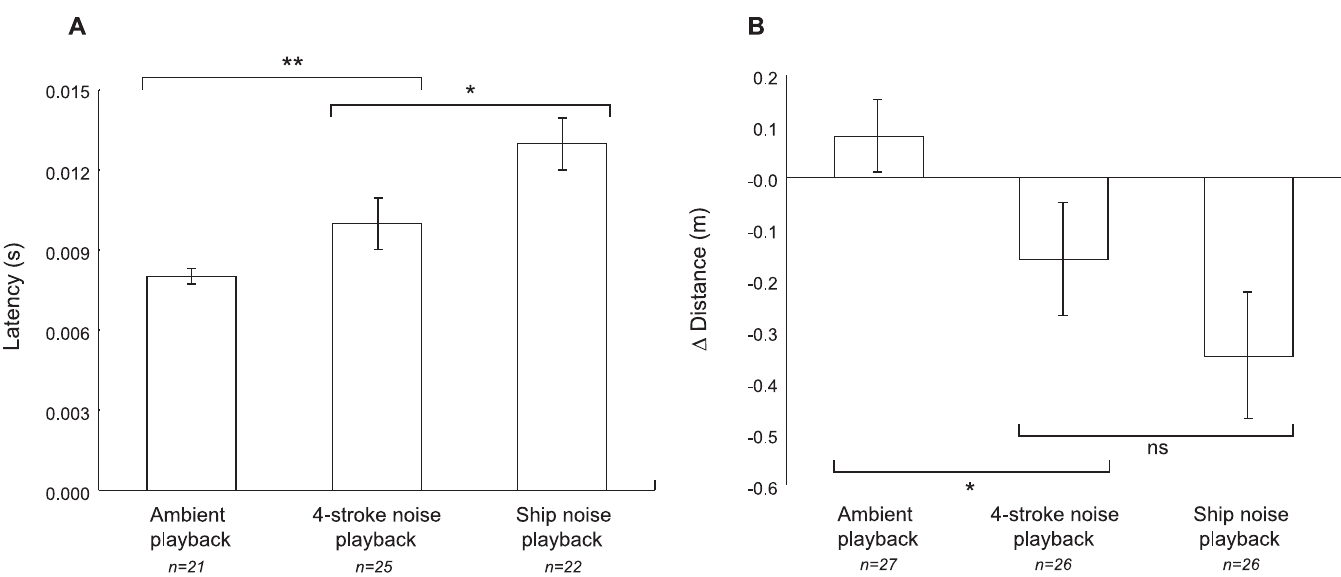
Fig 5. Effect of exposure to noise playbacks on routine swimming and escape response variables of Pomacentrus chrysurus . (A) Mean latency ( ± SE), (B) Change (mean ± SE) in distance covered between 56 s pre- and post-treatment. Data for latency were natural log transformed for analysis and standardised for distance to stimulus for analysis, but back-transformed covariate data are plotted. Asterisks above or below the bars represent significant differences between the planned comparisons ( � = p < 0.05; ns = no significant).